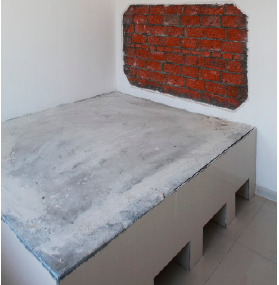
Figure 11. Traditional Kang in a rural house.